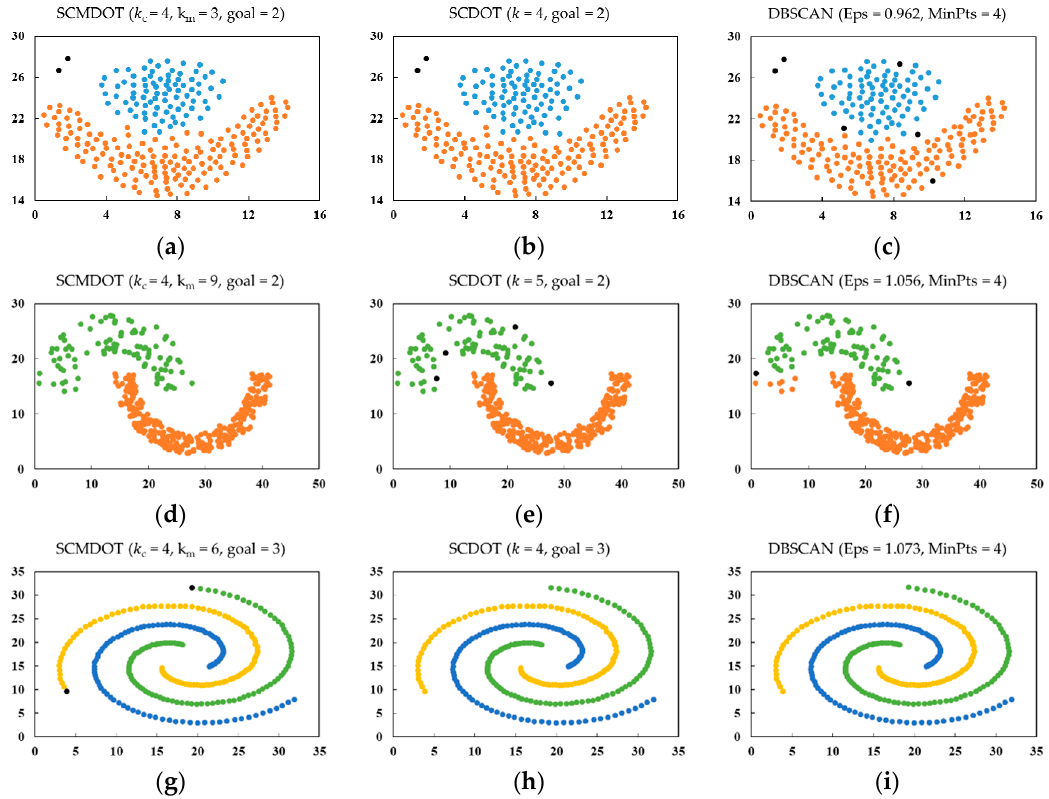
Figure 5. Illustration of clustering results in Experiment 1. ( a – c ) The clustering results of DS1; ( d – f ) The clustering results of DS2; ( g – i ) The clustering results of DS3.